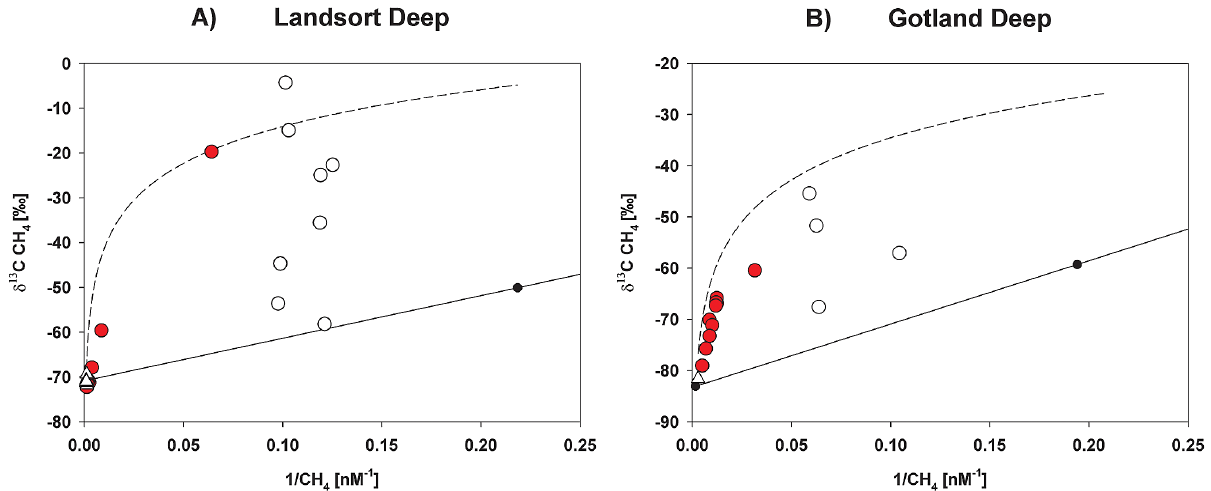
Fig. 5. Landsort Deep (A) and Gotland Deep (B) . δ 13 CCH 4 versus 1/CH 4 . Please note different scales for δ 13 CCH 4 . The solid lines denote mixing between deep and surface water, the dashed lines represent the oxidation trends based on a fractionation factor of α = 1 . 012, the open triangles indicate the anoxic zone, the red circles the redox zone and the open circles the oxic